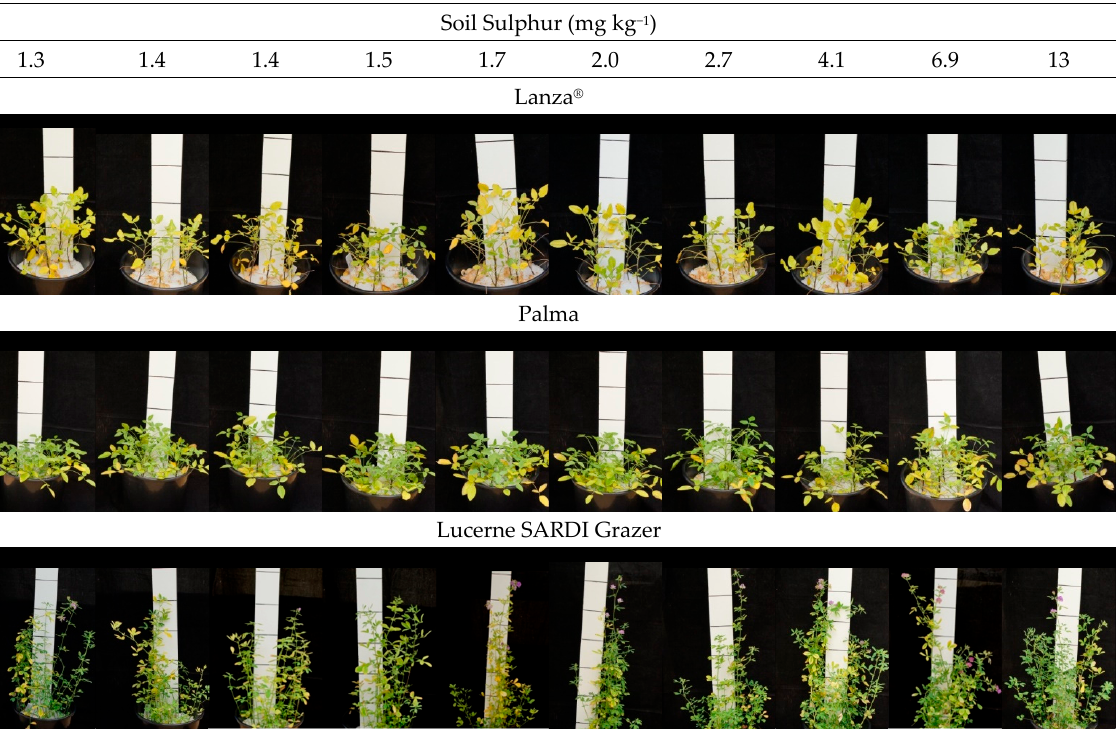
Figure 5. Images of pots containing 12-week-old Lanza ® (top), Palma (middle), and lucerne (bottom) grown in the glasshouse with differing levels of soil S. Black lines on large scale bars are 10 cm intervals.